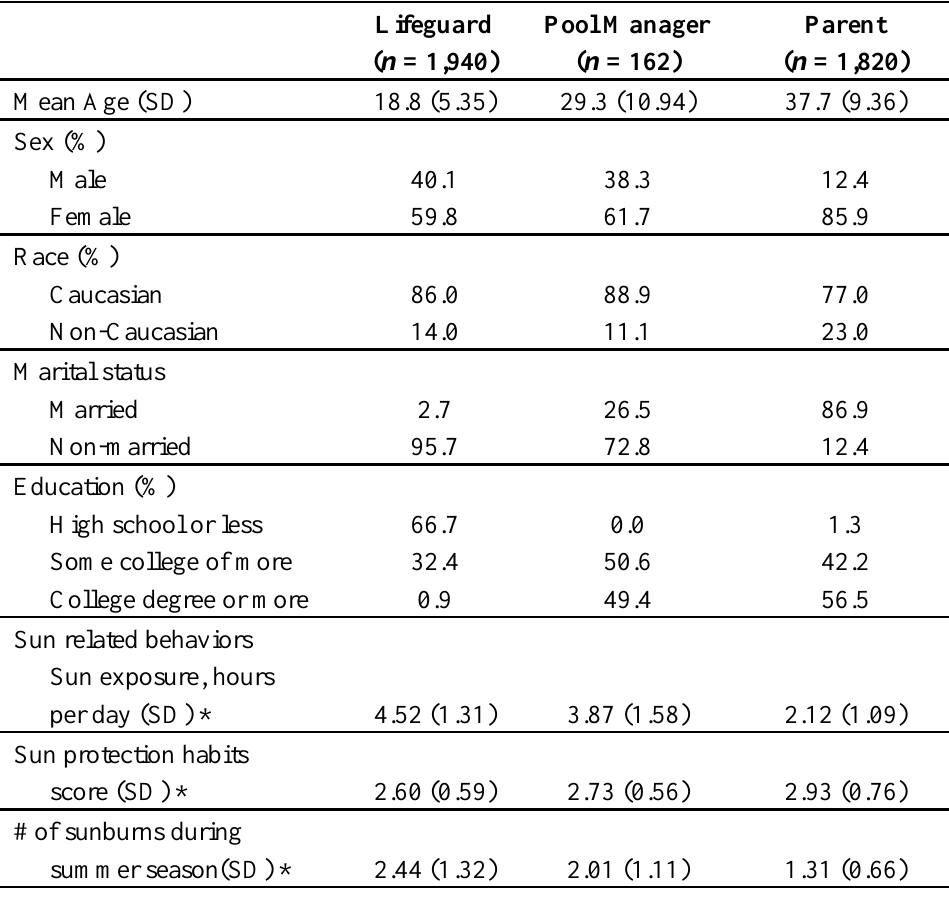
Table 1. Characteristics of Participants (N = 3,922), 2006, USA.